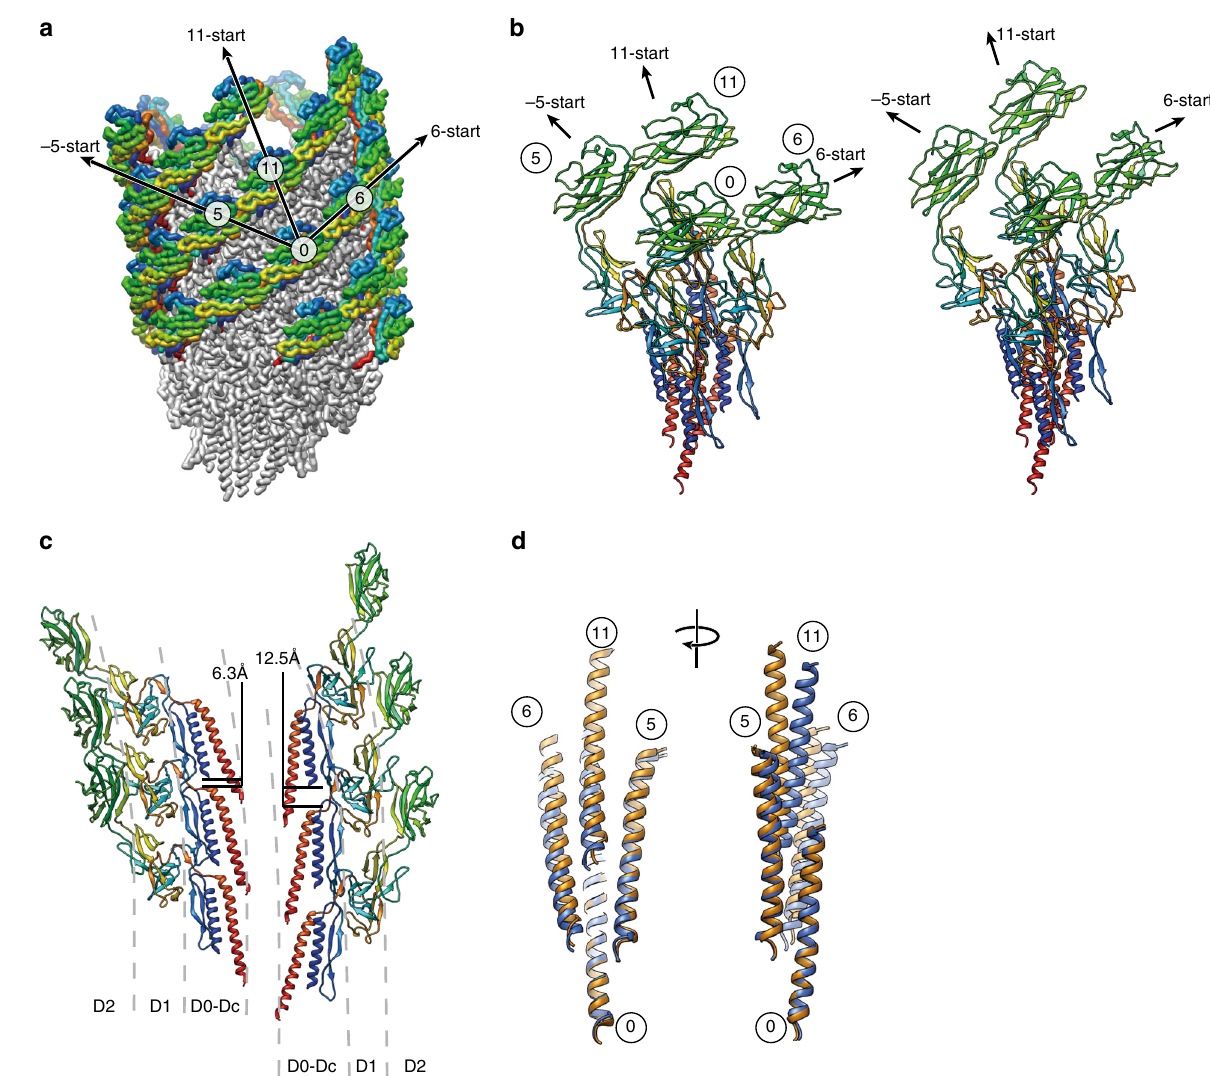
Fig. 3 Structural changes upon proto fi lament compression and extension. a Subunit array with number labels and the directions of the three major helical lines in the overall structure of the supercoiled hook. Only domain D2 is colored in rainbow from its N- to C-terminus to make it stand out. b Conformations and intersubunit interactions of four neighboring subunits around the shortest (compressed) and longest (extended) proto fi laments. A reference subunit is labeled 0 and the three neighboring subunits are labeled 5, 6 and 11 according to the three major helical directions of − 5-, 6- and 11-start, respectively. c The difference in the gap distance between the D0 domains along the proto fi lament for the shortest and longest. In b and c , FlgE subunits in ribbon representation are colored in rainbow from the N- to C-terminus. d Superimposition of the C-terminal helices of subunits around the shortest (blue) and longest (orange) proto fi